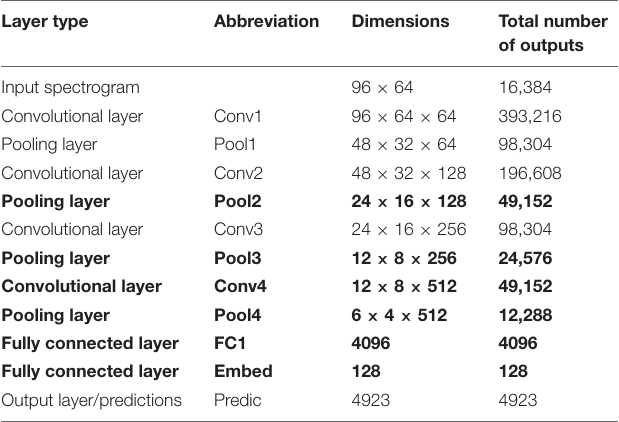
TABLE 1 | Dimensions of the input and each layer of the neural